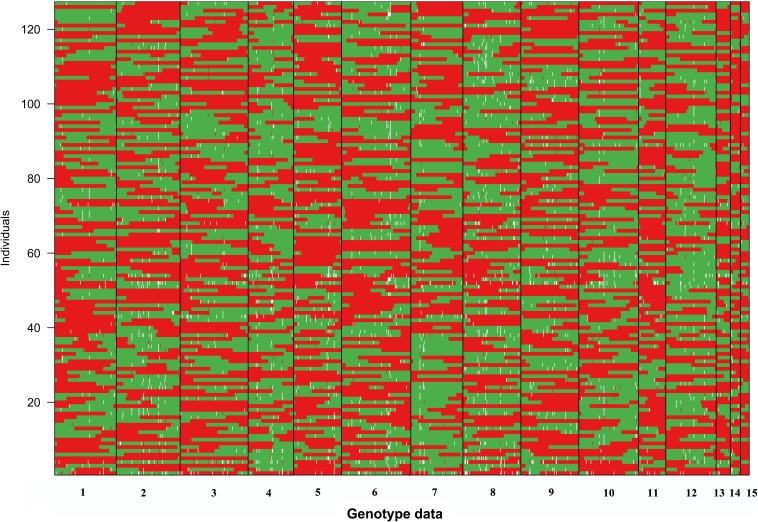
Visualization of the genotype of SSIs. The red segments originated from parent monokaryon CS-4, whereas the green segments are from 911 to 4. Missing data are shown in white.